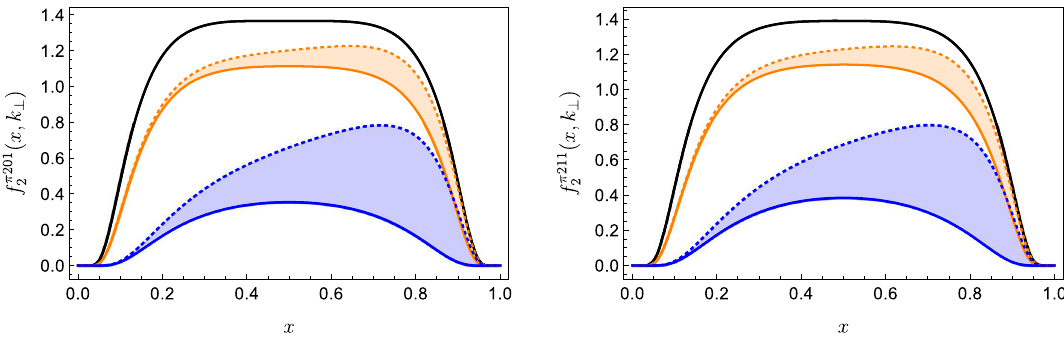
Fig. 8 Same of Fig. 7 but for the dynamical spin model of Ref. [44]. Left panel for the configuration A = 0 , B = 1. Right panel: for the configuration A = B = 1